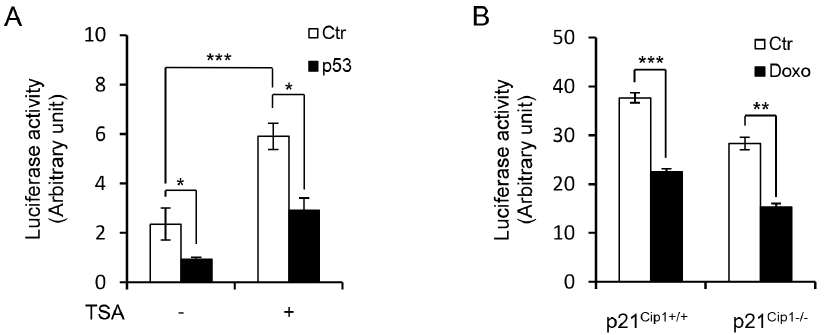
Figure 6. Repression of GFI1 by p53 is independent of HDACs and p21 Cip1 . (A) p53 2 / 2 HCT116 cells were transfected with GFI1 promoter ( 2 1933/ + 468 bp) luciferase reporter construct without or with p53 and treated with TSA (0.15 m M) 8 hrs later. Luciferase activities were measured 24 hrs after TSA treatment. (B) p21 Cip1 + / + and p21 Cip1 2 / 2 HCT116 cells were transfected with GFI1 promoter ( 2 1933/ + 468 bp) reporter construct and treated with Doxo (400 ng/ml) 8 hrs later. Luciferase activities were measured 16 hrs after Doxo